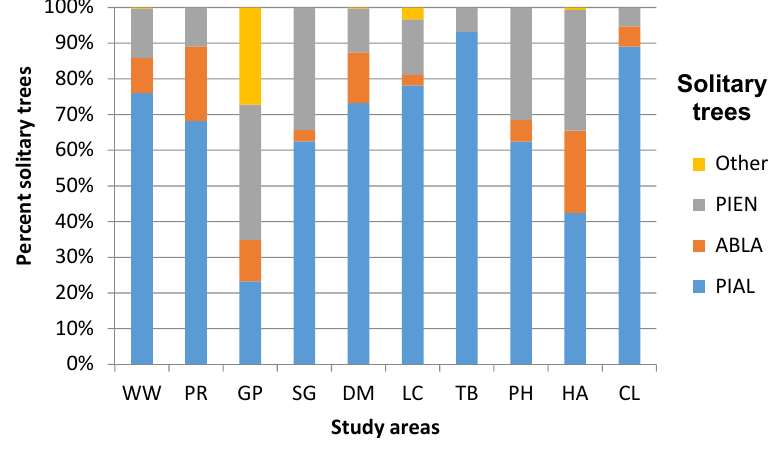
Figure 3. Percent composition of the solitary conifer tree community for each study area. See Table 3 for conifer species listed under “Other” for each study area. Conifer abbreviations are as follows: PIAL = whitebark pine ( Pinus albicaulis ), ABLA = subalpine fir ( Abies lasiocarpa ), PIEN = Engelmann spruce ( Picea engelmannii ), PICO = lodgepole pine ( Pinus contorta ), LALY = alpine larch ( Larix lyallii ), and PSME = Douglas-fir ( Pseudotsuga menziesii ). Study areas are abbreviation as follows: WW = Willmore Wilderness, PR = Parker Ridge, GP = Gibbon Pass, SG = Stanley Glacier, DM = Divide Mountain/White Calf Mountain, LC = Line Creek, TB = Tibbs Butte, PH = Paintbrush Divide/Holly Lake, HA = Hurricane Pass/Avalanche Basin, and CL = Christina